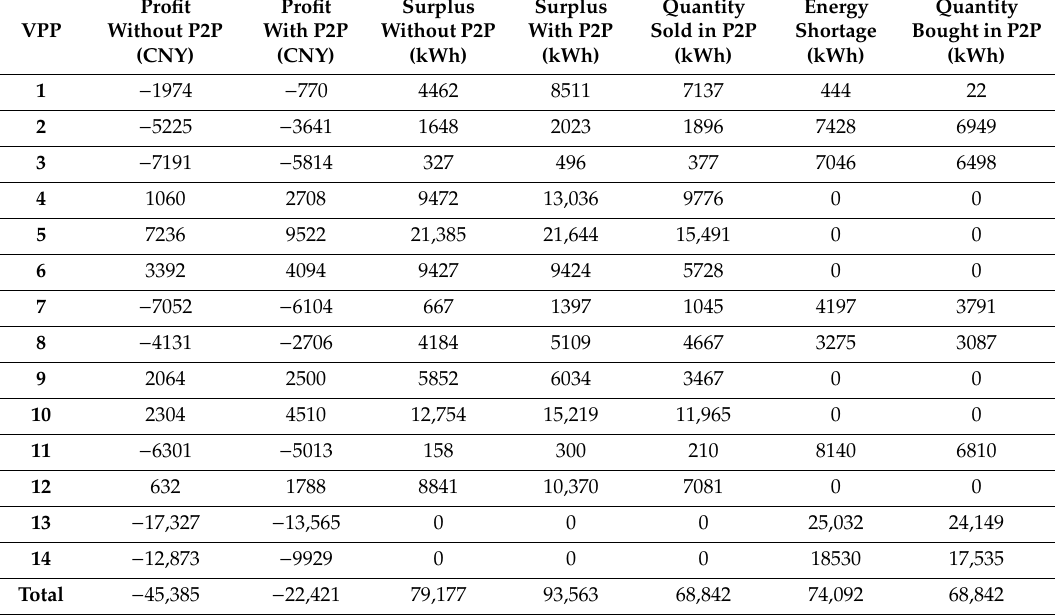
Table 5. Twenty-four hour accumulated profit and trade quantity of each VPP without P2P and with P2P trading.